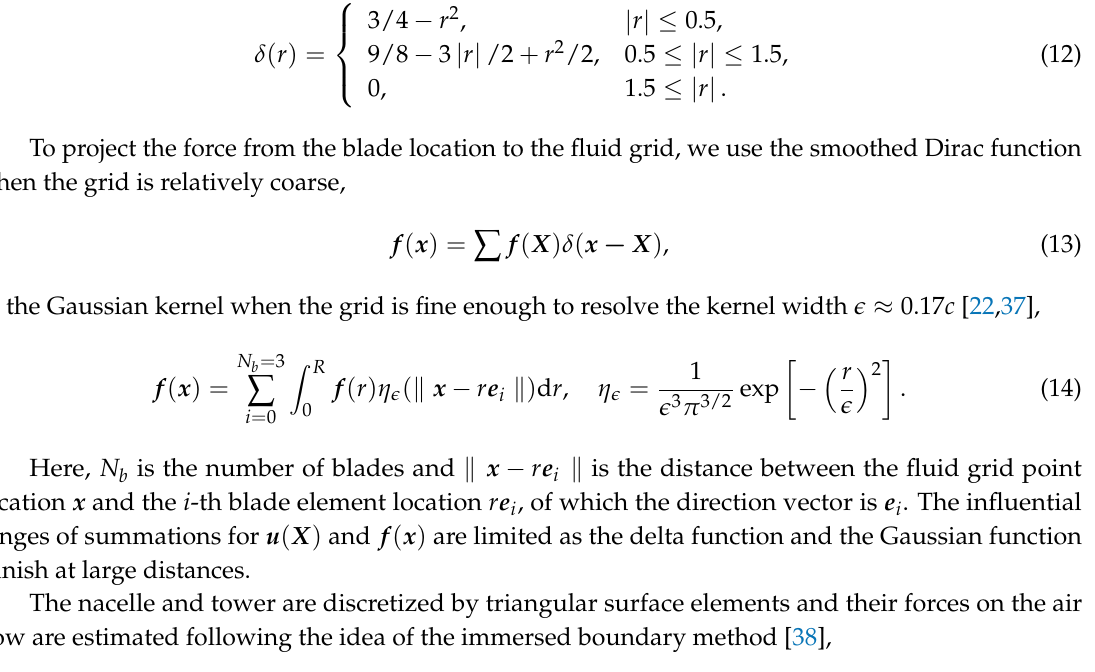
and a perpendicular (cid:107)